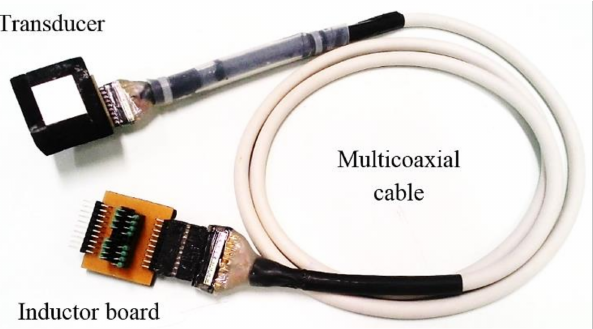
Figure 9. Complete transducer, with multicoaxial cable and board of matching